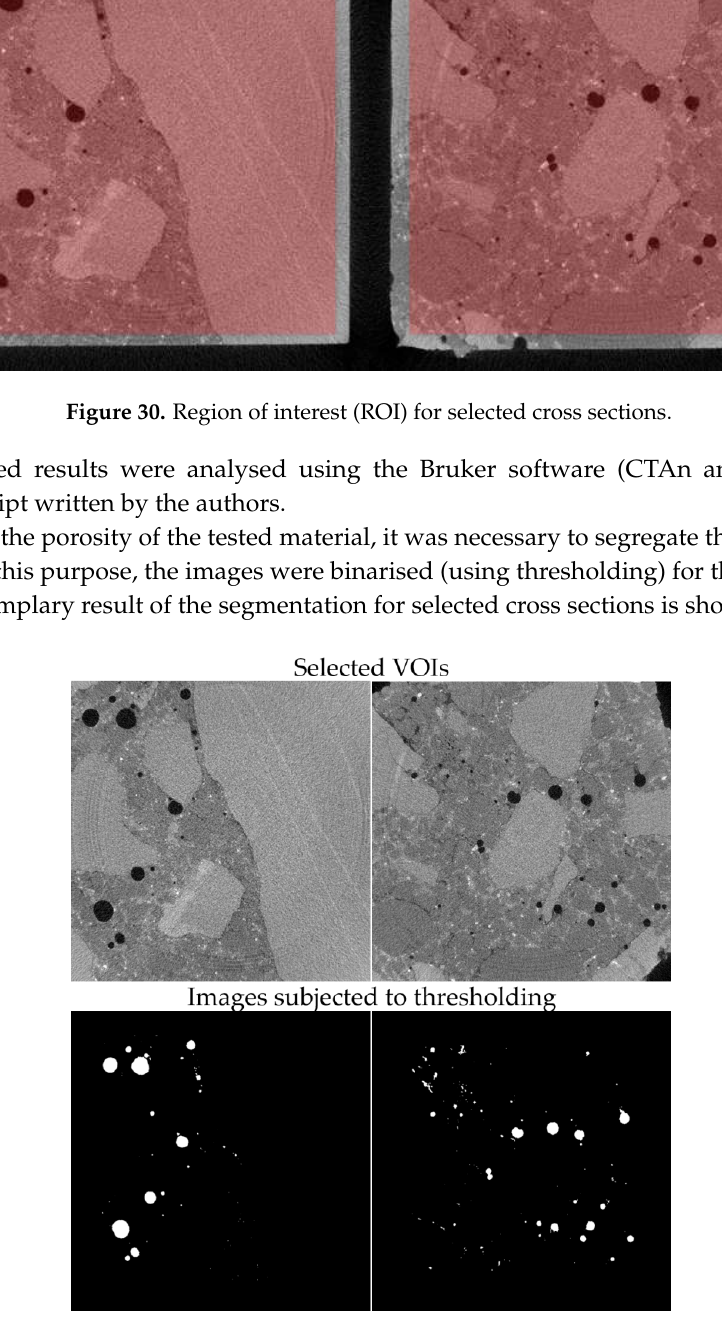
Figure 31. Segmentation of pores for selected cross sections.